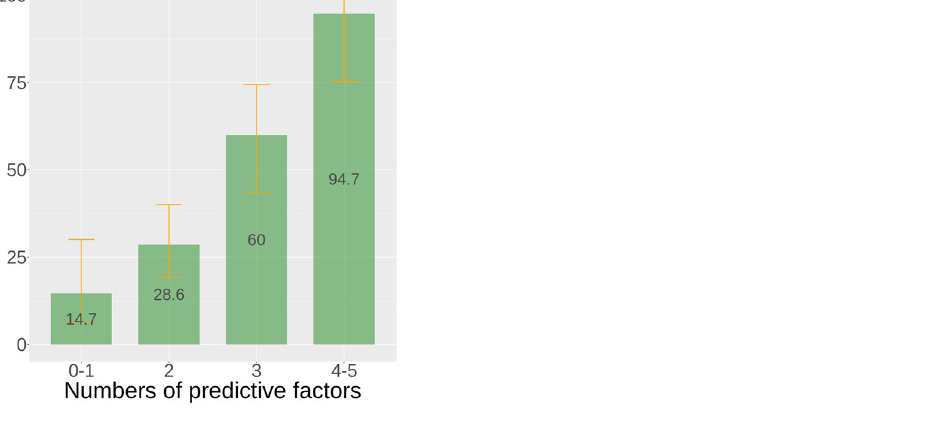
Figure 3. Numbers of predictive factors and detection rates of respiratory viruses. Error bars represent the 95% Wilson score confidence intervals of